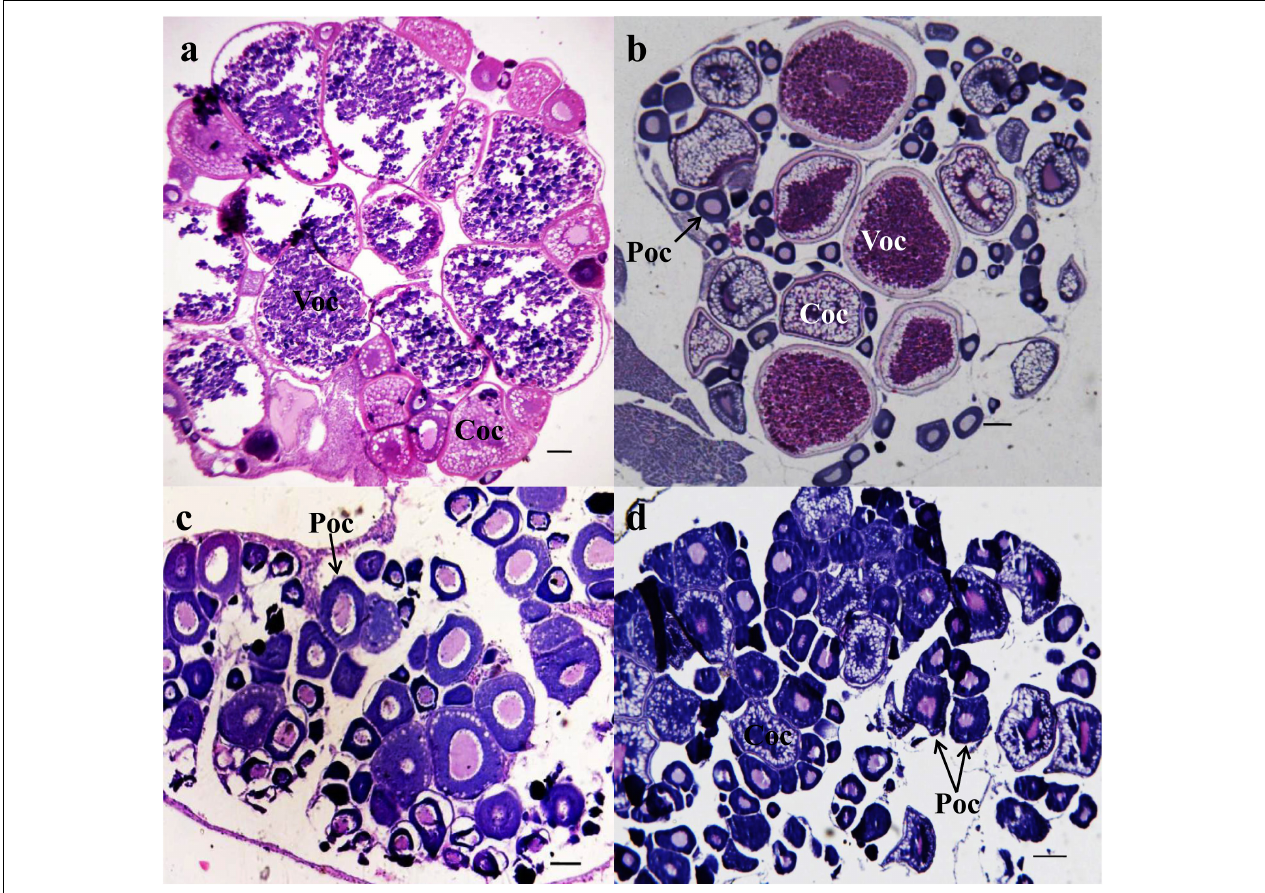
FIGURE 1 | Photomicrographs of transverse ovary sections of adult Gobiocypris rarus unexposed and exposed to methyltestosterone (MT) ( n = 6). H&E staining, scale bars = 150 µ m. (a) The 7-day control group ovary, (b) 25 ng/L of MT for 7-day exposure, (c) 50 ng/L of MT for 7-day exposure, and (d) 100 ng/L of MT for 7-day exposure. Voc, mature oocyte; Coc, pre-yolk oocyte; Poc, primary oocyte.